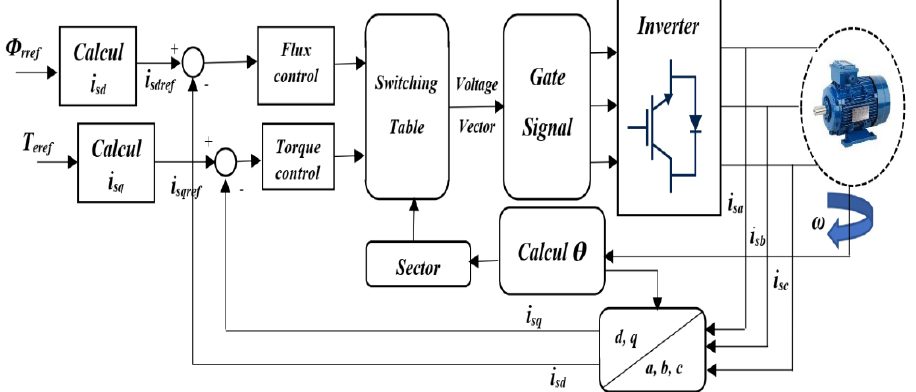
Figure 6. Combined vector control and direct torque control scheme.